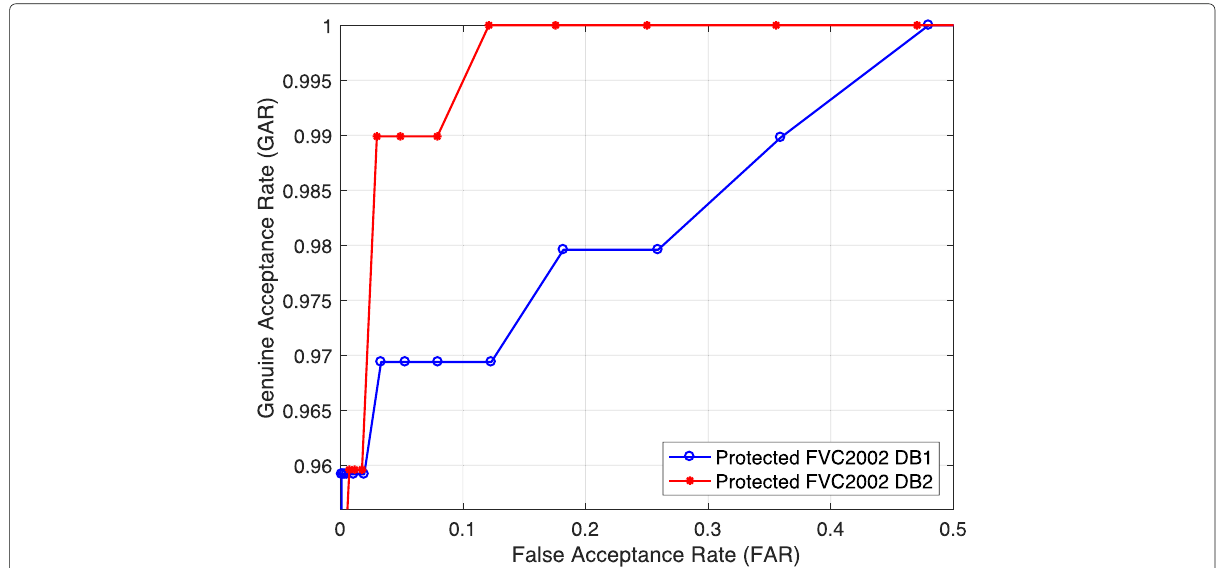
Fig. 6 The ROC curve under stolen-token scenario for FVC 2002 DB1 and